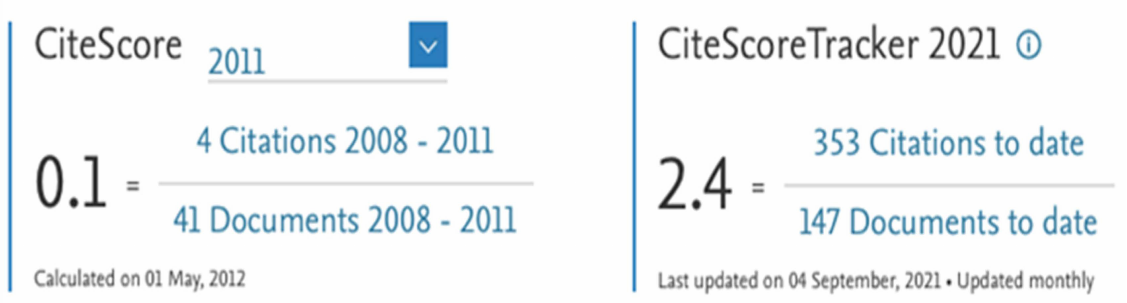
Figure 10. Citescore increasing trend for the analysed journal, values in 2011 (Citescore) and 2021 (Citescore